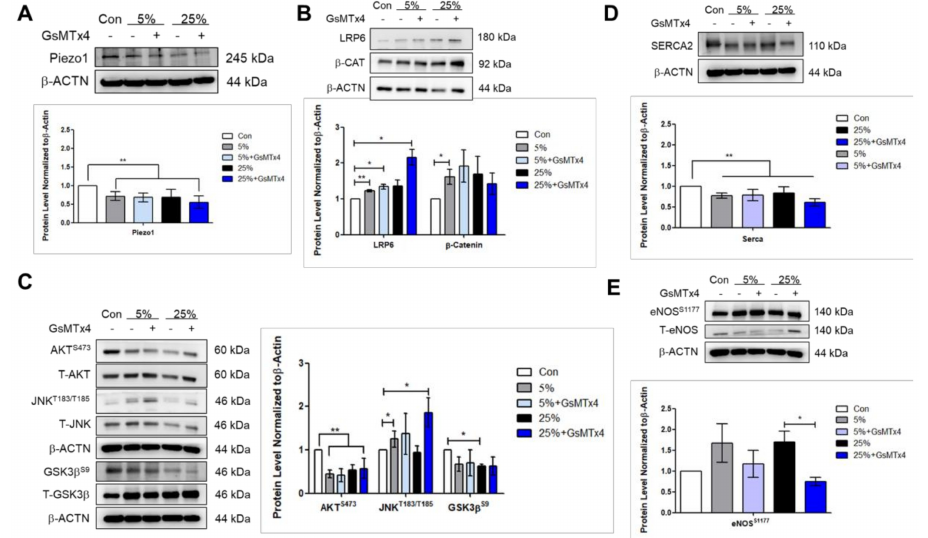
Figure 2. Cyclic stretch stimulates the low-density lipoprotein receptor-related protein 6 LRP6/ β -catenin signaling. ( A ) Cardiomyocytes analyzed by Phospho-kinase array at no stretch (control), 5%, 15%, and 25% 24 h of stretching. ( B ) Western blot performed to analyze the stretch-activated ion channel Piezo1 protein expression. Validation of the ( C ) phosphorylated-Ak transforming serine473 (AKT S473 ), phosphorylated-c-Jun N-terminal kinase threonine183/tyrosine185 (JNK T183/Y185 ), phosphorylated-glycogen synthase kinase-3 beta serine9 (GSK3 β S9 ), total AKT, JNK, and GSK3 β , ( D ) wingless integrated (Wnt) signaling molecules LRP6, and β -catenin. Data represent at least three independent experiments in SEM ± SD. *, p value < 0.05, ***, p value < 0.001.